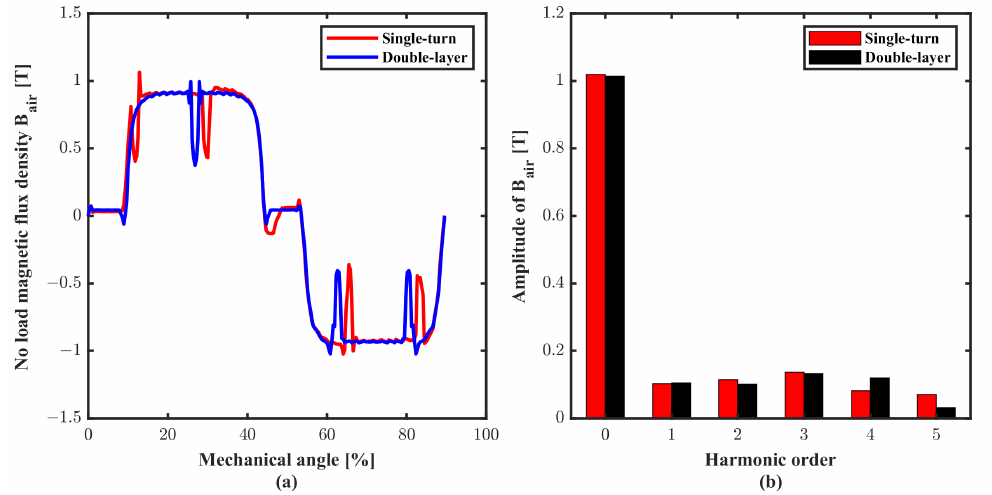
Figure 7. ( a ) No load air-gap magnetic flux density distribution. ( b ) Harmonic components of air-gap magnetic flux